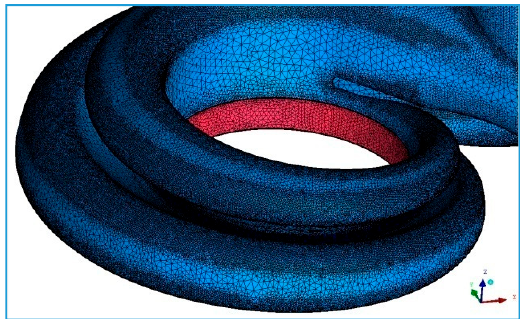
Figure 1. Unstructured grid detail on the two volute branches. In magenta the volute outlet section.